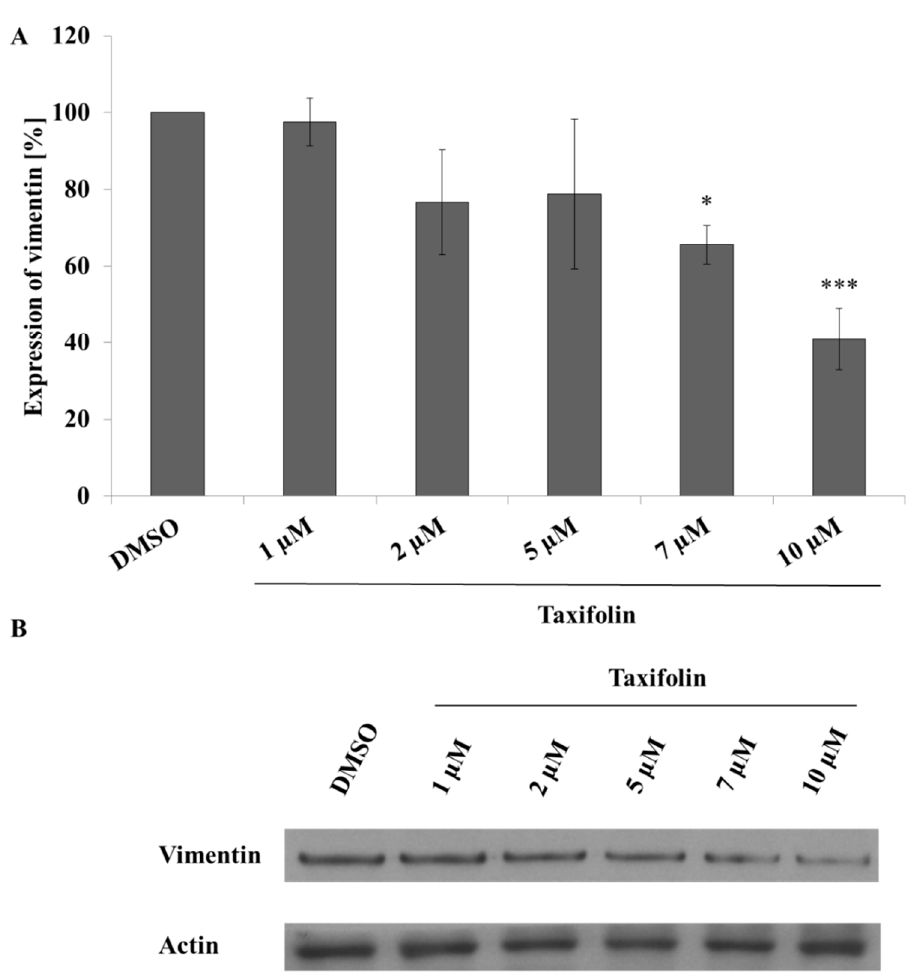
Figure 3. Modulation of vimentin expression by taxifolin. Panel ( A ): Hep G2 cells were seeded and incubated with different concentrations of taxifolin or negative control (contains only DMSO). Vimentin expression was evaluated by Western blot after 24 h of incubation. Each bar represents mean ± SD of three independent experiments. Panel ( B ): representative Western blot. * p < 0.05 (*** p < 0.001) versus negative control.